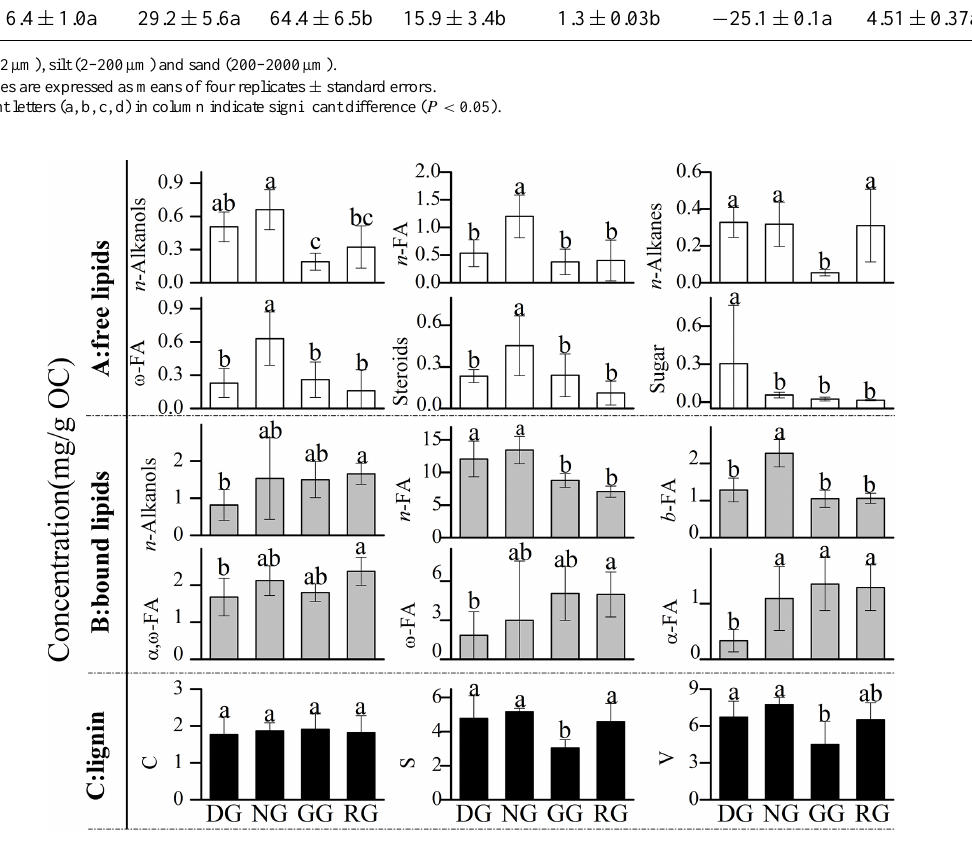
Figure 3. Concentrations (mgg − 1 OC) of free lipids, bound lipids and lignin-phenols in the grassland soils in Inner Mongolia. DG: degraded grassland by overgrazing; NG: native grassland without apparent anthropogenic disturbance; GG: groundwater-sustaining grassland; RG: restored grassland from previous cultivated land. The values presented are the means of four replicates ± standard errors. Different letters (a, b, c, d) above each column bar indicate significant difference ( P < 0 .